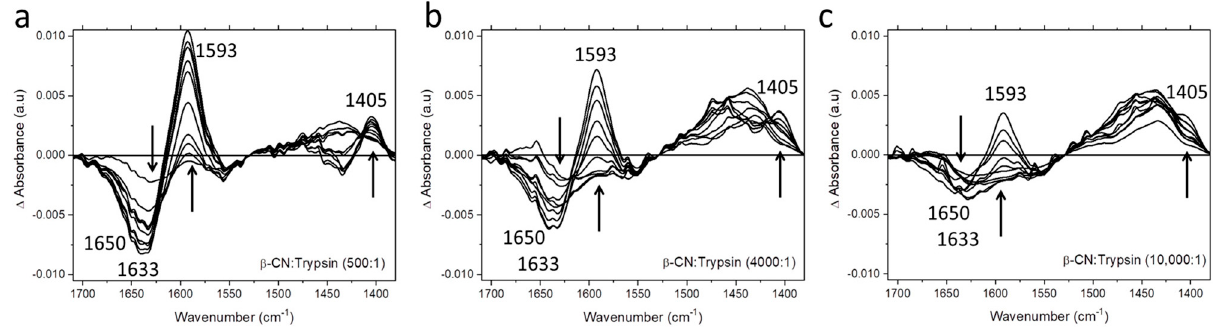
Figure 4. The FTIR difference spectra for β -CN digested by trypsin recorded at 37 °C for the S 0 / E 0 ratios of ( a ) 500, ( b ) 4000, and ( c ) 10,000 ( w / w ). The difference spectra were calculated by subtraction of the first spectrum recorded at t = 1 min from each of the absorbance spectra recorded during enzymatic reaction. The arrows represent the amide changes of β -CN during digestion as a function of time from 1 min to 90 min.